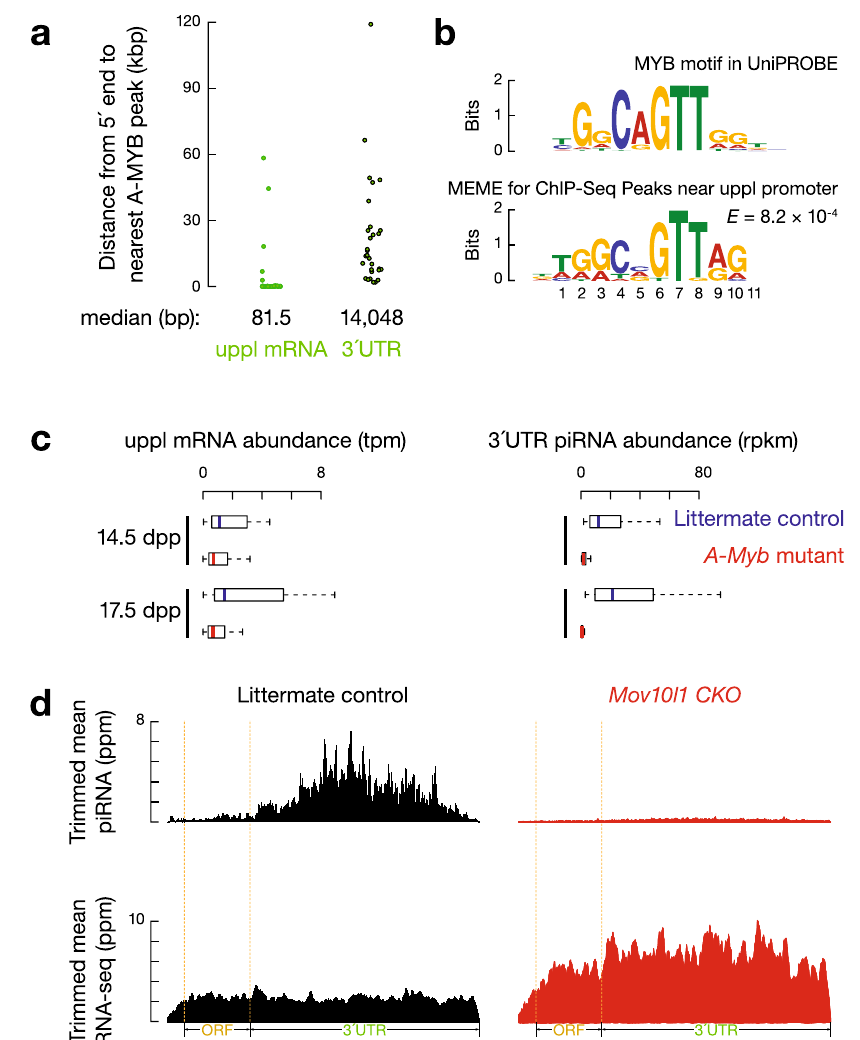
Fig. 1 mRNA precursors of 3 ′ UTR piRNA are regulated by A-MYB. a The distance from the annotated transcription start site of each mRNA that comes from 3 ′ UTR piRNA-producing loci (uppl) (left, n = 30) and from the 5 ′ -ends of uppl mRNA 3 ′ UTRs (right, n = 30) to the nearest A-MYB ChIP-seq peak. bp: base pair, kbp: kilobase pair. b Top, the MYB motif from the mouse UniPROBE database. Bottom, MEME-identi fi ed sequence motif in the A-MYB ChIP-seq peaks near the uppl mRNA transcription state sites. E -value computed by MEME measures the statistical signi fi cance of the motif. The information content is measured in bits and, in the case of DNA sequences, ranges from 0 to 2 bits. A position in the motif at which all nucleotides occur with equal probability has an information content of 0 bits, while a position at which only a single nucleotide can occur has an information content of 2 bits. c Boxplots showing the abundance of uppl mRNA (left) and 3 ′ UTR piRNA (right) per uppl gene in A-Myb mutants (red) and their heterozygous littermates (blue) in testes at 14.5 and 17.5 dpp. Dpp: days postpartum, tpm: transcript per million, rpkm: reads per kilobase million. uppl n = 30. Box plots show the 25th and 75th percentiles, whiskers represent the 5th and 95th percentiles, and midlines show median values. d Aggregated data for 3 ′ UTR piRNA abundance (upper) and uppl mRNA abundance (bottom) on uppl mRNAs (10% trimmed mean) from adult Mov10l1 CKO/ Δ testes (left) and Mov10l1 CKO/ Δ Neurog3-cre (right). Signals are aligned to the transcriptional start site (5 ′ cap) and site of polyadenylation (3 ′ PolyA) and further aligned to the ORF regions. Dotted lines show the translation start codon (ORF Start) and stop codon (ORF End). The x -axis shows the median length of these regions. Ppm: parts per